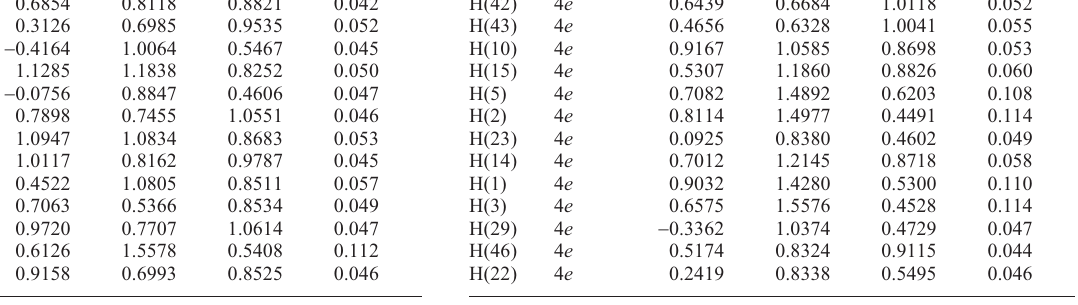
Table 3. Atomic coordinates and displacement parameters (in Å 2 )